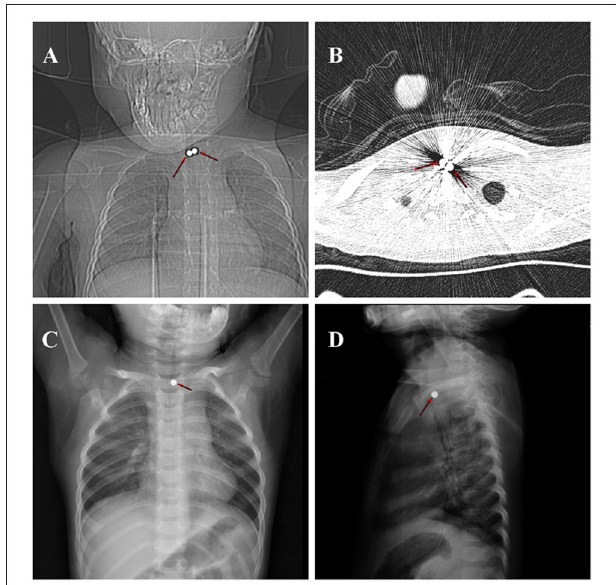
FIGURE 1 | Location mapping and horizontal CT of the trachea and bronchi revealed two round high-density shadows (red arrow) of diameter ∼ 0.5cm that appeared to be located in the upper part of the trachea at the level of the chest (A,B) . A residual round, metallic, foreign body shadow was apparent at the entrance of the thoracic cage on chest frontal and lateral DR performed at 6h post-operatively (C,D) .